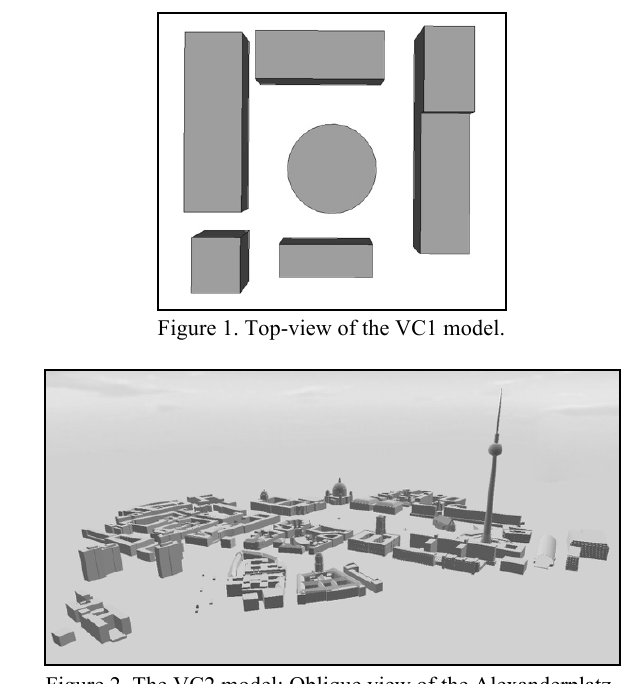
Figure 2. The VC2 model: Oblique view of the Alexanderplatz, Berlin in Germany (Source: